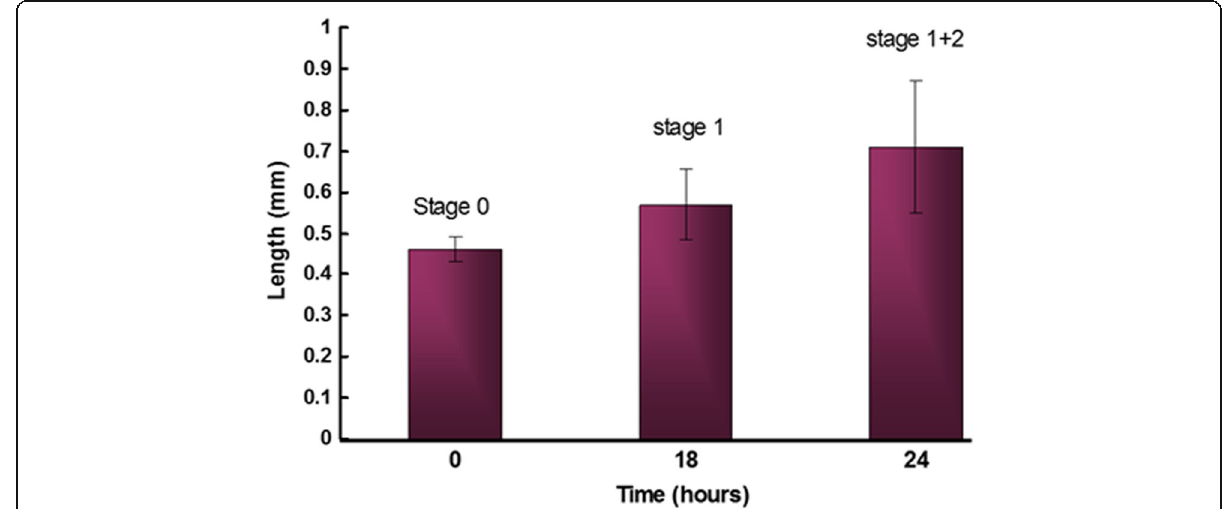
Fig. 5 Lengths and stages of A. tunisiana under the effect of enrichment duration. Stages are according to Weisz scheme (1946)